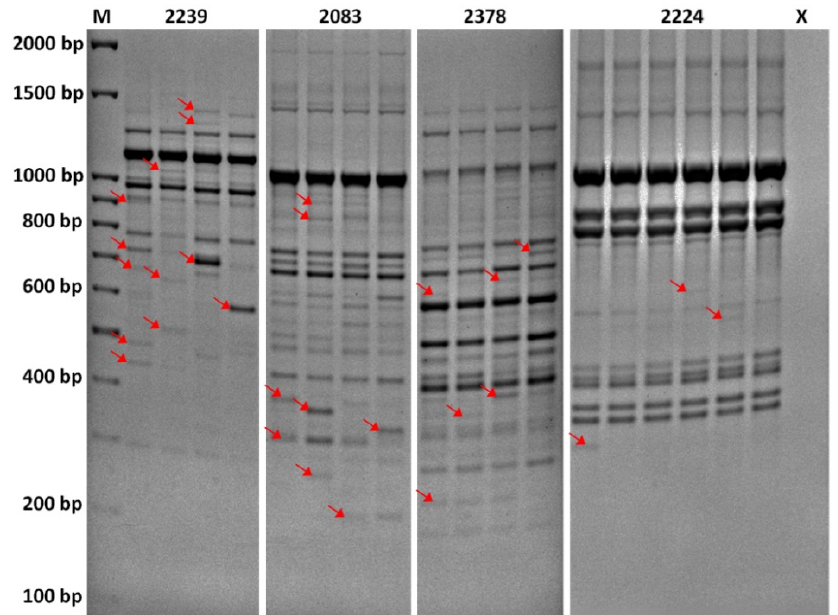
Figure 1. Repeatability of DNA profiles by iPBS primers 2239, 2083, 2378, and 2224. The lanes represent DNA fingerprints of a single individual. To identify unreliable regions of DNA profiles, the testing for differences in banding patterns was carried out by repeated PCR with a single DNA sample for each of the primers, a few times after PCR optimization. This information was used in gel interpretation to better score for the presence and absence of individual bands in different regions. The bands considered unreliable with low repeatability are indicated by the